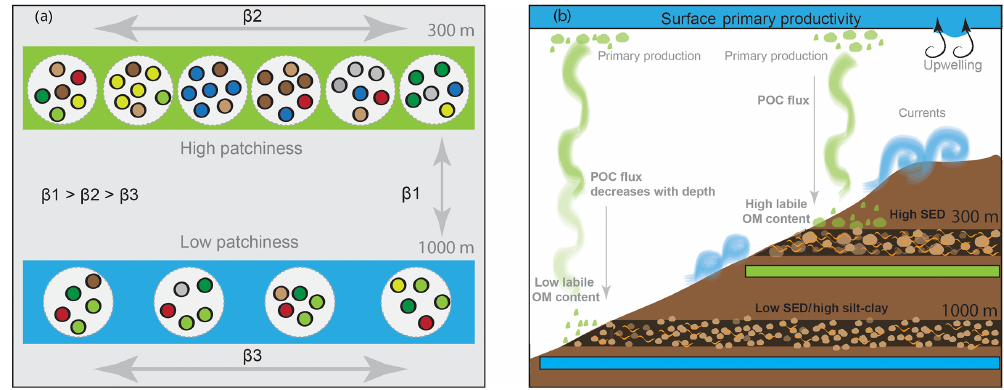
Figure 9. Scheme showing (a) how beta diversity varied across stations and between bathymetrical transects. The green bar represents the “shallow” transect and the light blue bar the “deep” transect. Grey circles inside the bars represents the stations sampled at each transect. Coloured circles inside grey circles refer to the variability in nematode genus composition within station and across stations. It illustrates the higher densities and turnover (beta 2) found at the “shallow” stations and the lower turnover (beta 1) found at the “deep” stations. (b) The figure reveals the main environmental factors responsible for beta diversity between both depth transects. Upwelling effects, primary production, currents, and decrease of POC (particulate organic carbon) with increasing depth are considered to be correlated with turnover. The fate of organic matter produced at the surface varies with depth, where deeper areas will receive lower labile organic matter (OM) when compared to shallower areas. This figure also illustrates the higher variability in sediment composition at the “shallow” transect when compared to the deeper